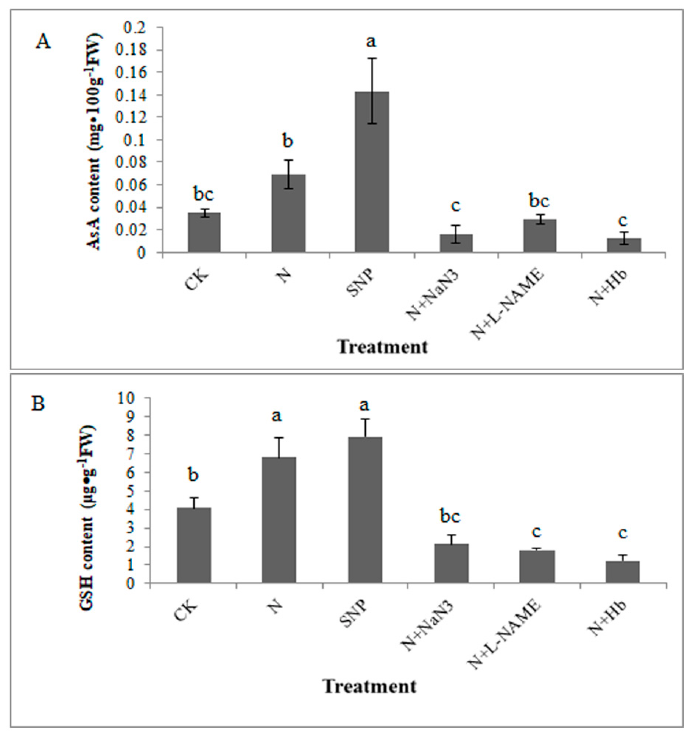
Figure 2. E ff ects of NO and NH 4 + :NO 3 − ratio on the contents of redox state of ascorbate and glutathione in mini Chinese cabbage leaves under low light stress. The seedlings cultivated in black containers filled with di ff erent solutions, CK (NH 4 + :NO 3 − = 0:100); N (NH 4 + :NO 3 − = 10:90); SNP (100 µ mol / L); N + Hb (0.1%); N + L-NAME (25 µ mol / L); N + NaN 3 (50 µ mol / L) were treated for 7 days. Then the contents of AsA ( A ) and GSH ( B ) from mini Chinese cabbage leaves were analyzed. Bars indicated the SE (n = 3). Significant di ff erences ( p < 0.05) between treatments are indicated by di ff erent letters, for low light